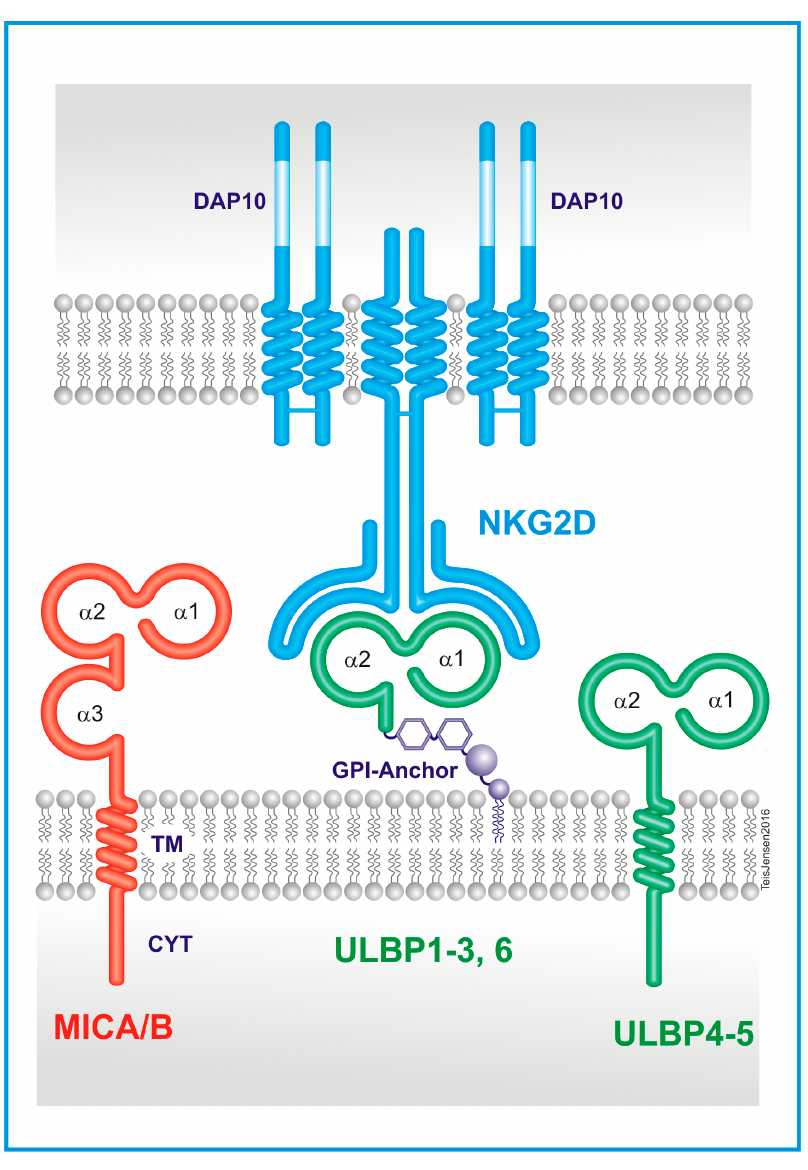
Figure 1. Protein structures of Natural Killer Group 2D (NKG2D) and its ligands. NKG2D is a disulfide-linked homodimer, transmembrane protein that can bind to two adapter molecules, DAP10 (DNAX-activating protein of 10 kDa), also a homodimer. NKG2D ligands are eight different MHC I-like molecules. Four of these (MHC class I polypeptide-related sequence (MIC) A/B and UL16 binding protein (ULBP) 4/5) are bound to the cell membrane by transmembrane (TM) domains with a cytoplasmic tail (CYT), while the other four (ULBP1-3 and 6) are glycophosphatidylinositol (GPI)-anchored. Each has two or three α domains.